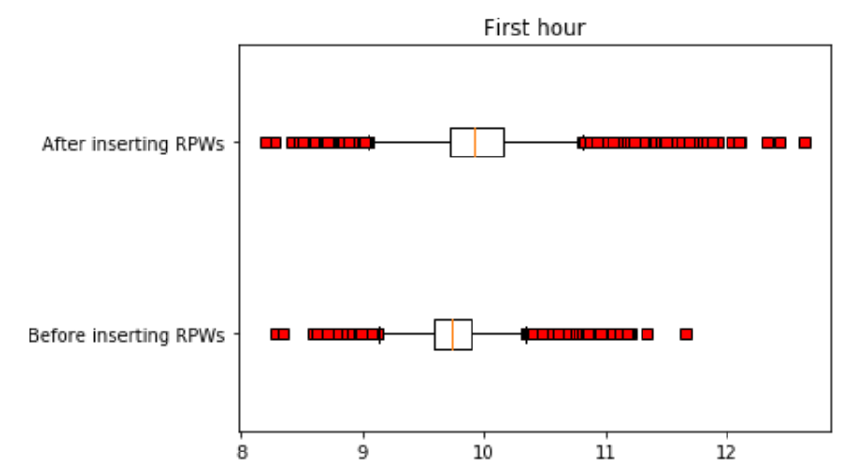
Figure 16. Box-plot graph for the inside sensor, before and after infestation for the first hour.